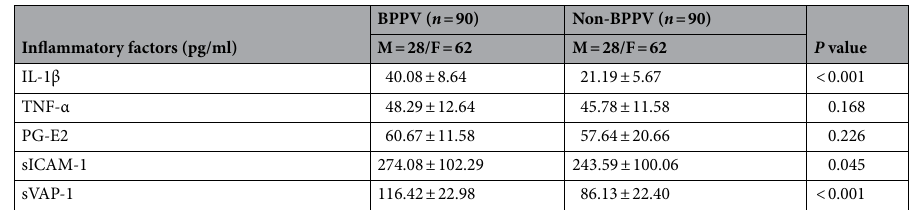
Table 2. Inflammatory factors. BPPV benign paroxysmal positional vertigo, IL-1β Interleukin-1β, PG-E2 prostaglandin-E2, sICAM-1 soluble intercellular adhesion molecule-1, sVAP-1 soluble vascular adhesion protein-1, TNF-α tumor necrosis